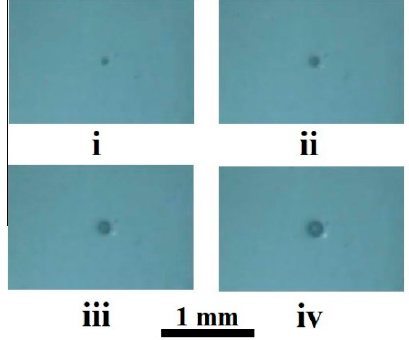
Figure 3. Sizing of an individual embryo in the course of depressurization. The initial conditions = 11.5 MPa, T = 310 K. The values of P ext are: i—5.86 MPa; ii—5.75 MPa; iii—5.71 MPa; are: P in P = 11.5 MPa, T = 310 K. The values of ext are: in ext iv—5.65